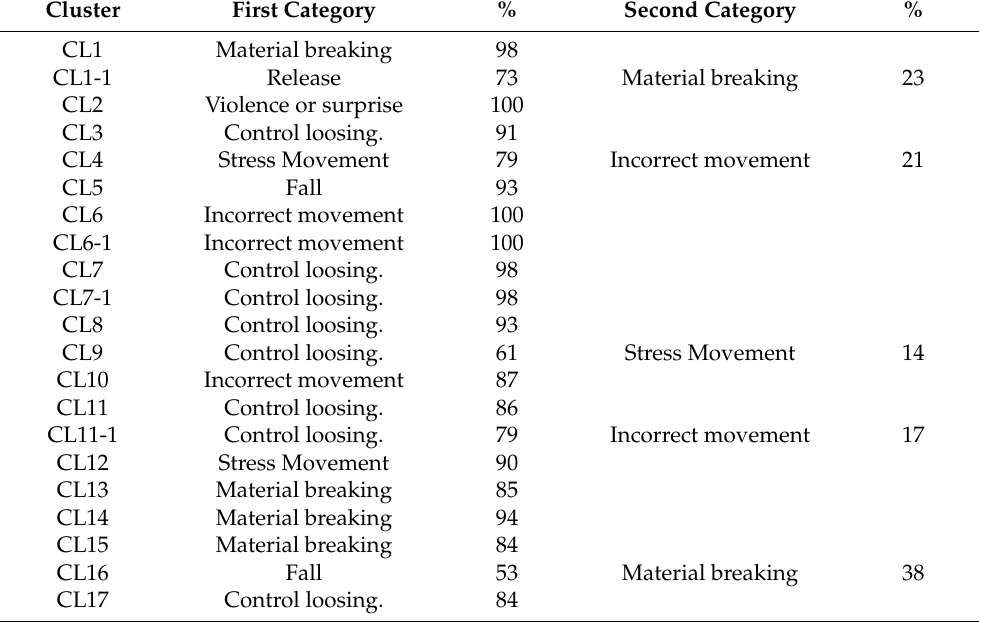
Table A3. Clusters description